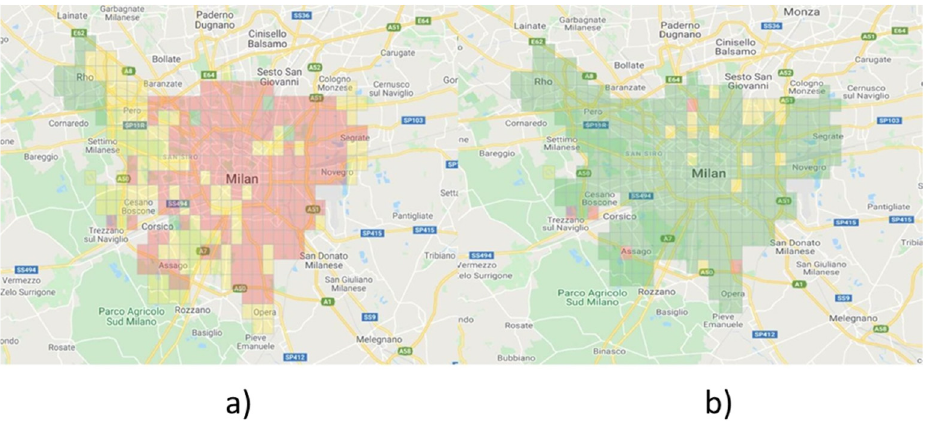
Figure 17. Pollution levels ( a ) before and ( b ) during